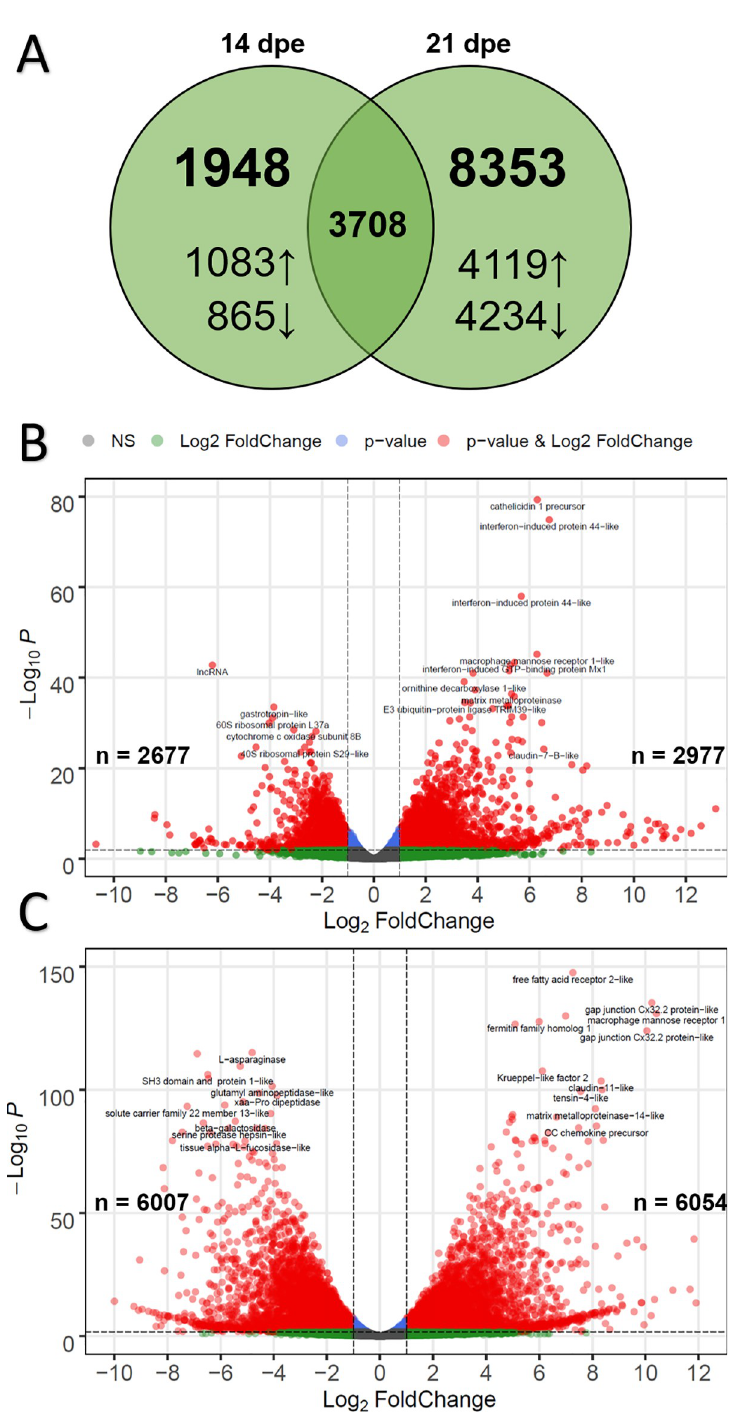
Fig 6. Differential expression results for susceptible fish at 14- and 21-days post exposure (dpe) to Ceratonova shasta . A) Venn diagram indicating the number of differentially expressed genes overlapping at 14- and 21 dpe. Arrows indicate up- vs. downregulation. B) Volcano plot of differential gene expression for susceptible fish at 14 dpe. Each dot represents the average value of one gene across three biological replicates. Red indicates the gene was significant at the FDR-adjusted p-value and Log 2 -Foldchange threshold, blue is significantly only by p-value, green only by Log 2 -Foldchange, and gray were not significant by either metric. B) Same as (A), but for susceptible fish at 21 dpe.